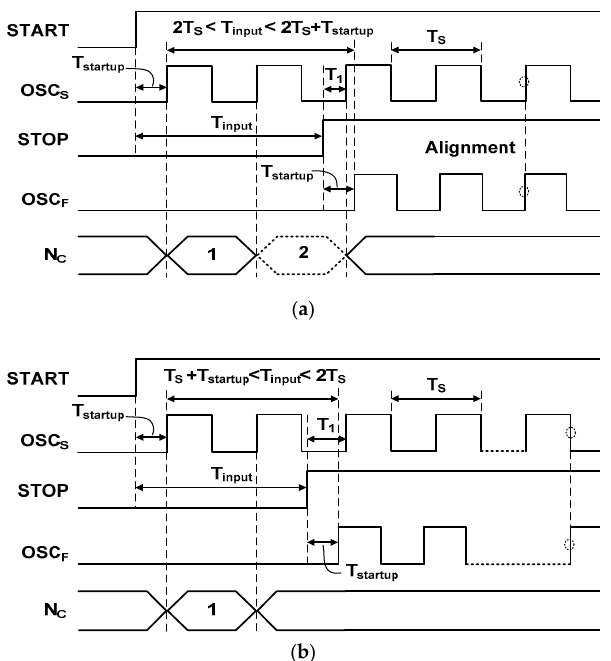
Figure 6. Waveform of two cases of the input time for a large T startup . ( a ) Incorrect counting by the startup time. ( b ) Correct counting.